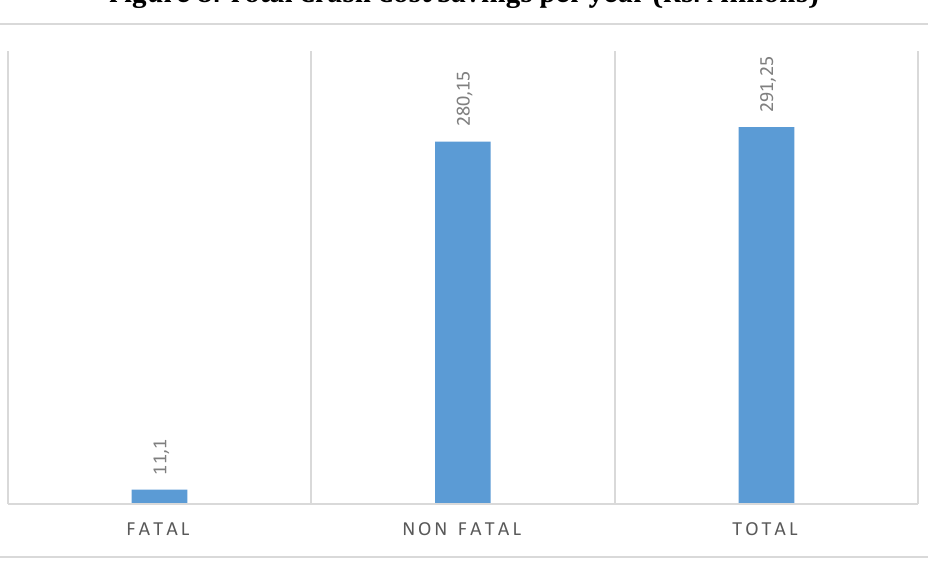
Figure 8: Total Crash Cost Savings per year (Rs.